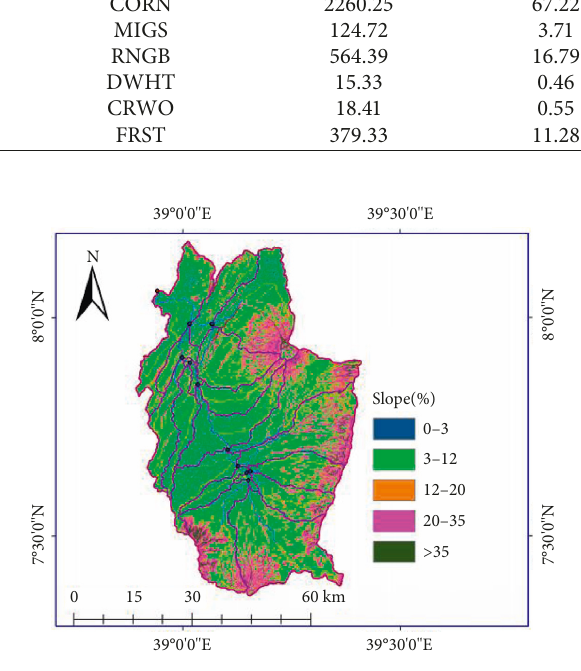
Figure 4: Slope distribution in the Ketar River